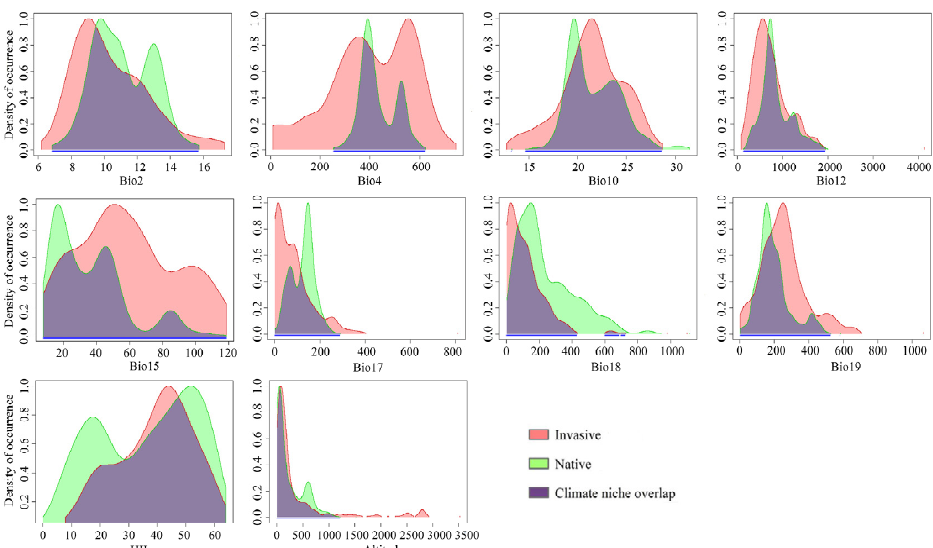
Figure 8. Predicted niche occupancy profiles. Bio2: mean diurnal range. Bio4: temperature seasonality. Bio10: mean temperature of the warmest quarter. Bio12: annual precipitation. Bio15: precipitation seasonality. Bio17: precipitation of driest quarter. Bio18: precipitation of warmest quarter. Bio19: precipitation of coldest quarter. HII: human influence index.